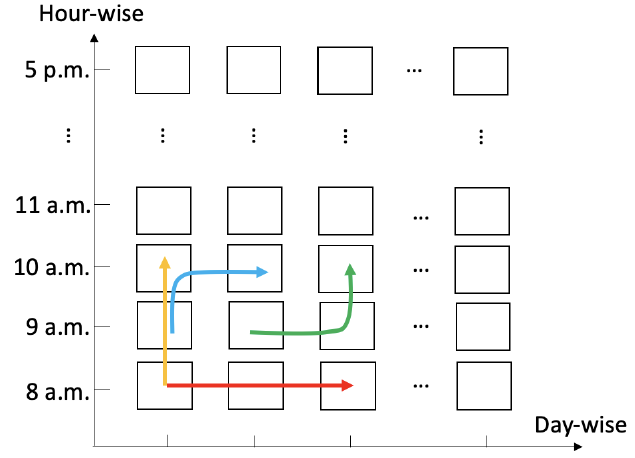
Figure 7. Illustration of the proposed two-dimensional RNN.